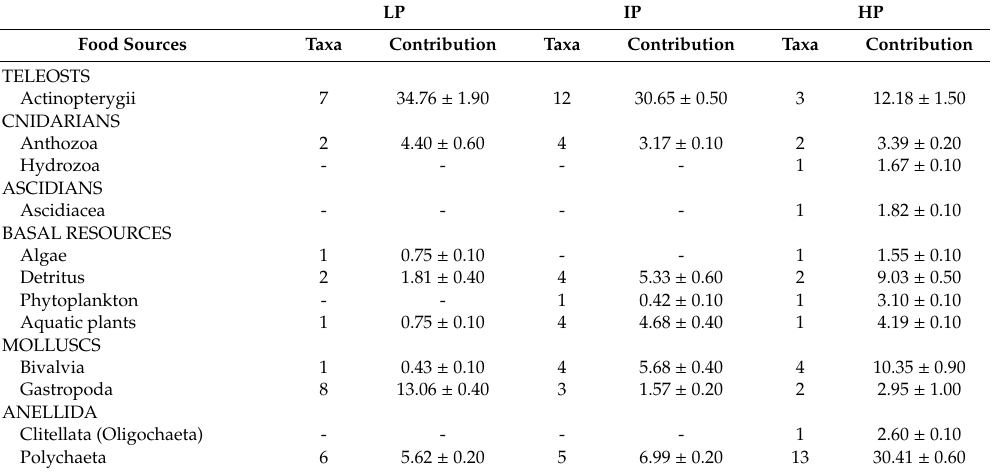
Figure 5. Contribution to the diet of Anguilla anguilla ( a ) and Diplodus annularis ( b ) of basal food sources (white), invertebrates (black) and fish (grey) in the lakes with low (LP), intermediate (IP) and high (HP) eutrophication. The overall contribution of basal resources, invertebrates and fish is reported as the mean (%) ± s.e. Di ff erent letters (a,b,c) within panels indicate di ff erences between lakes in the contribution of food sources to the diet ( χ 2 -test, p -value < 0.001). Table 3. Proportional contribution (in %) of food sources to the diet of A. anguilla in each lake, obtained from ITU-based mixing models. LP: low anthropogenic pressure, IP: intermediate anthropogenic pressure, HP: high anthropogenic pressure. The contribution of each food source is reported as the mean ( ± s.e.). “Taxa” indicates the number of taxa belonging to the respective group in the diet of A. anguilla. The overall contribution of basal resources, invertebrates and fish is reported as the mean (%) ± s.e. Di ff erent superscript letters (a,b,c) indicate di ff erences between lakes in the contribution of categories of food sources to the diet ( χ 2 -test, p -value < 0.05). For details please refer to the methods